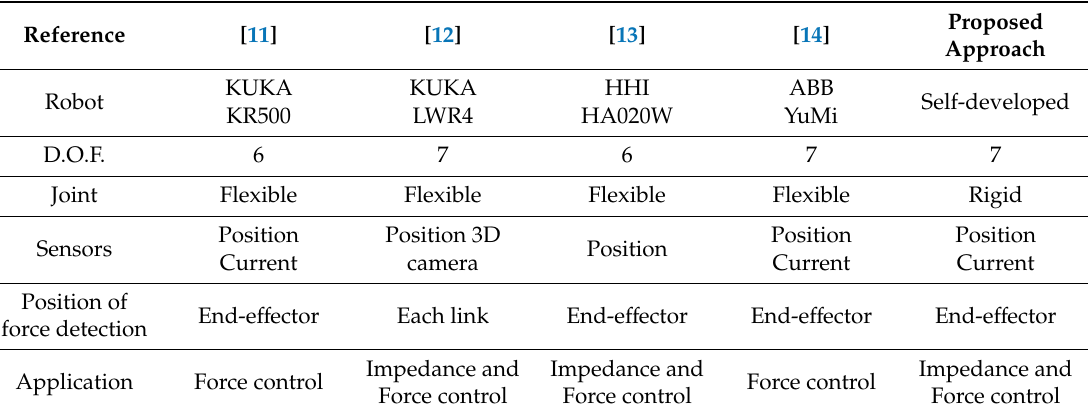
Table 1. Comparison of virtual force sensor